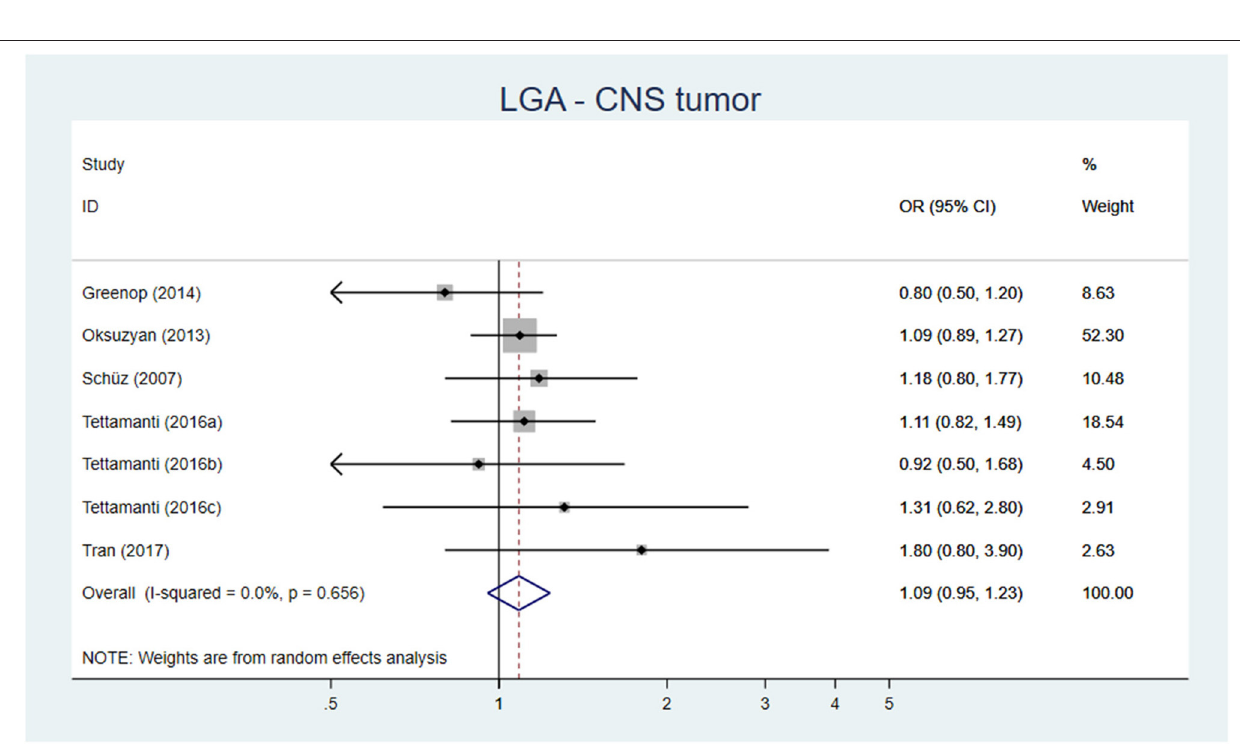
FIGURE 4 | Forest plot describing the association between LGA and CNS